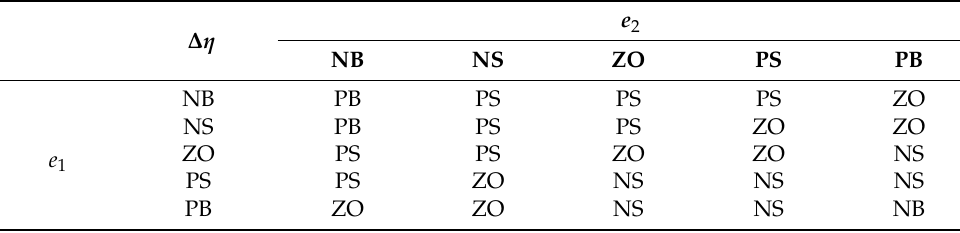
Table 1. Fuzzy rules of Δ𝜂 .